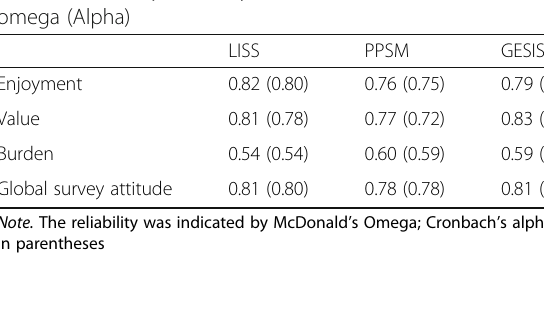
Table 2 Reliability of survey attitude (sub)scales.